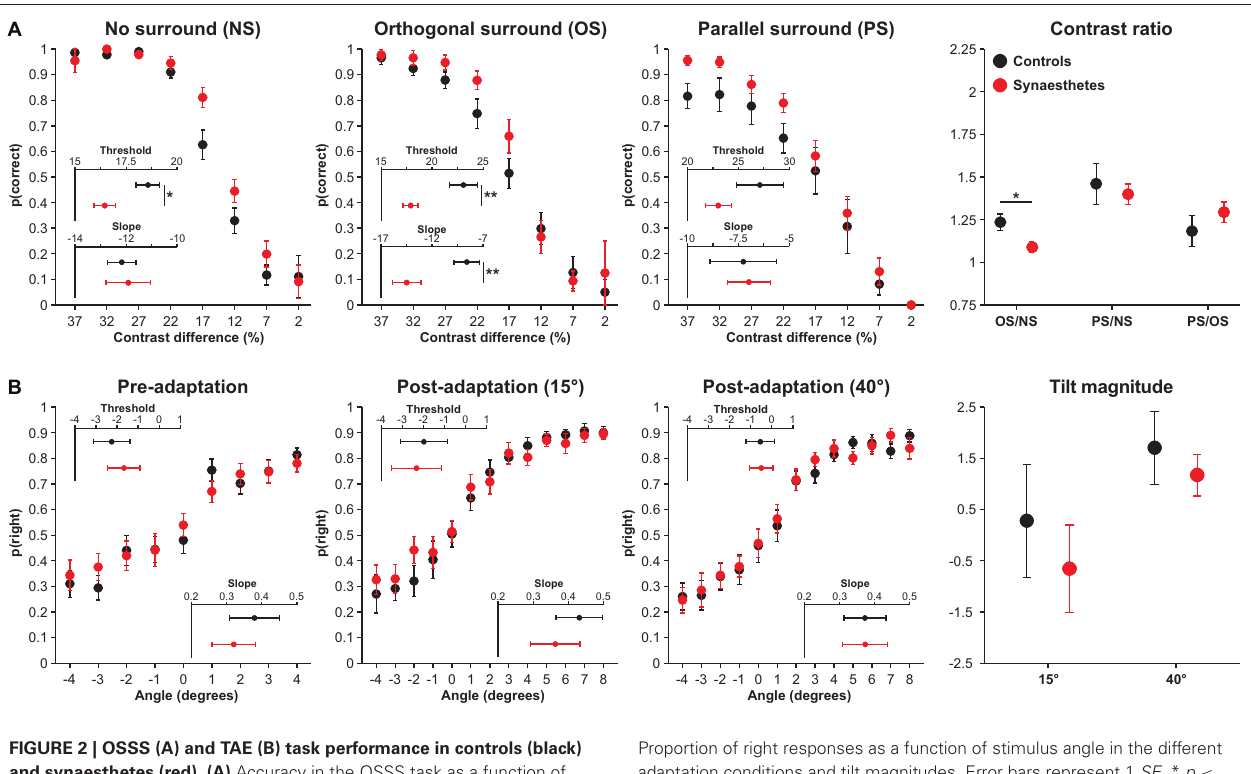
FIGURE 2 | OSSS (A) and TAE (B) task performance in controls (black) and synaesthetes (red) . (A) Accuracy in the OSSS task as a function of target contrast difference in the different surround conditions and ratios. (B)